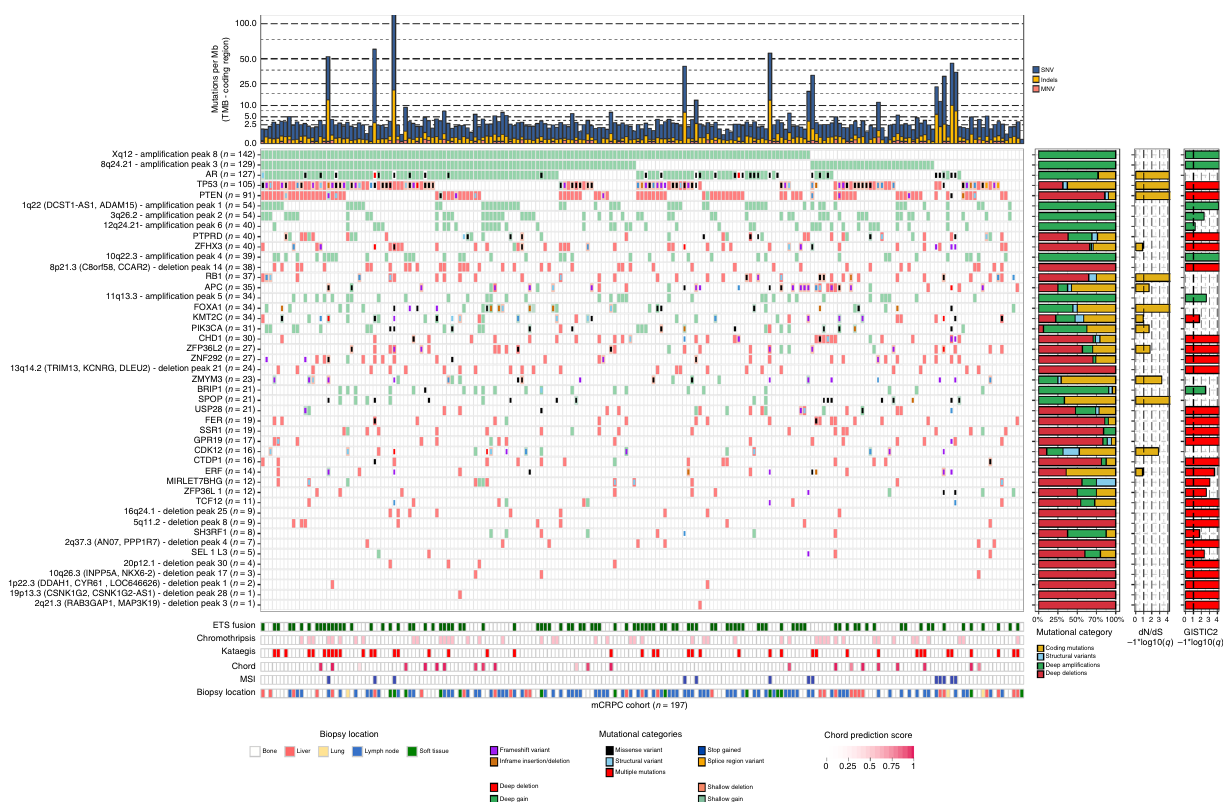
Fig. 2 mCRPC shows multiple recurrent somatic alterations affecting several oncogenic pathways. Based on d N /d S ( q ≤ 0.1) and GISTIC2 focal peak ( q ≤ 0.1) criteria, we show the genes and focal genomic foci that are recurrently mutated, ampli fi ed, or deleted in our mCRPC cohort of 197 patients. The upper track (top bar plot) displays the number of genomic mutations per Mbp (TMB) per SNV (blue), InDel (yellow), and MNV (orange) category in coding regions (square-root scale). Samples are sorted based on mutual-exclusivity of the depicted genes and foci. The heatmap displays the type of mutation(s) per sample; (light-)green or (light-)red backgrounds depict copy-number aberrations while the inner square depicts the type of (coding) mutation(s). Relative proportions of mutational categories (coding mutations [SNV, InDels, and MNV] (yellow), SV (blue), deep ampli fi cations [high-level ampli fi cations resulting in many additional copies] (green), and deep deletions [high-level losses resulting in (near) homozygous losses] (red)) per gene and foci are shown in the bar plot next to the heatmap. Narrow GISTIC2 peaks covering ≤ 3 genes were reduced to gene-level rows if one of these genes is present in the d N /d S ( q ≤ 0.1) analysis or is a known oncogene or tumor-suppressor. For GISTIC2 peaks covering multiple genes, only deep ampli fi cations and deep deletions are shown. Recurrent aberrant focal genomic foci in gene deserts are annotated with their nearest gene. Signi fi cance scores ( – 1*log10 ( q )) of the d N /d S and GISTIC2 analysis are shown on the outer-right bar plots; bars in the GISTIC2 signi fi cance plot are colored red if these foci were detected as a recurrent focal deletion and green if detected as a recurrent focal gain. Per sample, the presence of (predicted) ETS fusions (green), chromothripsis (light pink), kataegis (red), CHORD prediction score (HR-de fi ciency) (pink gradient), MSI status (dark blue), and biopsy location are shown as bottom